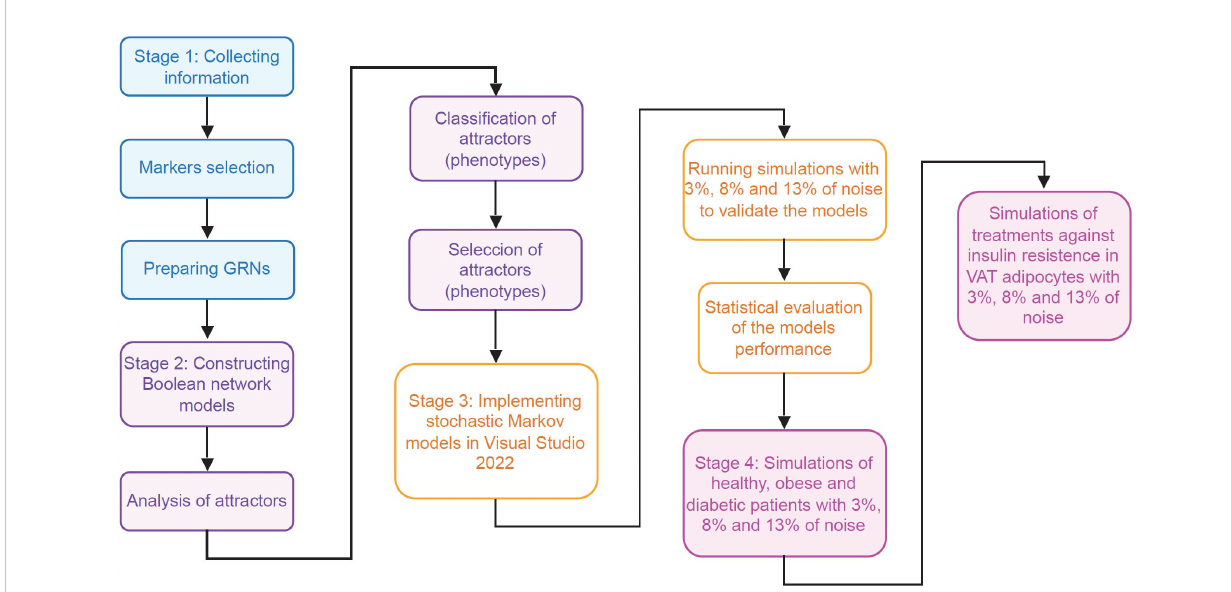
FIGURE 2 Flowchart of the methodology. This work was carried out in four different stages. In the fi rst stage (blue rectangles) the necessary information was collected to model the main VAT cells. In the second stage (purple rectangles) models of Boolean networks of CD4+ T lymphocytes, macrophages and adipocytes (Supplementary Information) were built and evaluated. In the third stage (yellow rectangles), the information of previous stages was used to build and validate stochastic models based on Markov chains of adipocytes, CD4+ T lymphocytes, and VAT-resident macrophages. Finally, in the fourth stage (pink rectangles), exploratory simulations were carried out to study the operation of the VAT in different pathophysiological contexts and its response to possible pharmacological